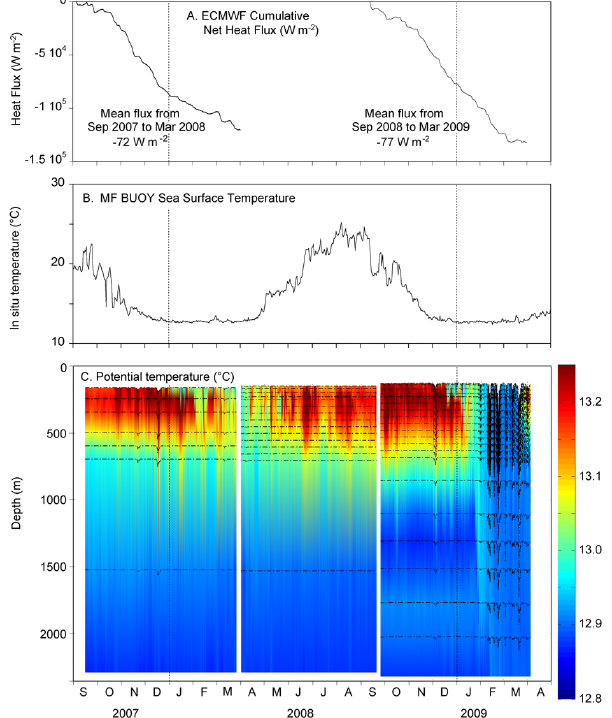
Fig. 4. Time series of (A) surface cumulative net heat losses, (B) sea surface temperature measured at the M´et´eo-France buoy in the con- vection area, and (C) vertical distribution of potential temperature at the SC2350 site from September 2007 to April 2009. Black dotted lines indicate the depth of the different temperature sensors. Note the deepening of the instruments during the winter 2008–2009 due to the strong currents.